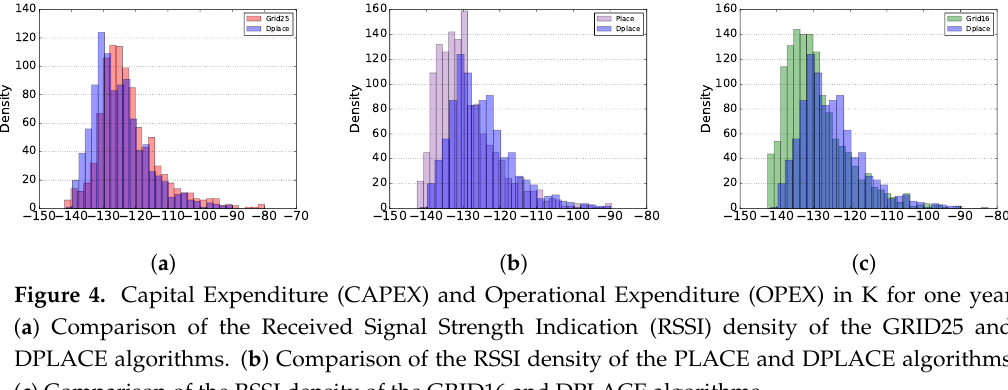
Figure 4. Capital Expenditure (CAPEX) and Operational Expenditure (OPEX) in K for one year. ( a ) Comparison of the Received Signal Strength Indication (RSSI) density of the GRID25 and DPLACE algorithms. ( b ) Comparison of the RSSI density of the PLACE and DPLACE algorithms. ( c ) Comparison of the RSSI density of the GRID16 and DPLACE